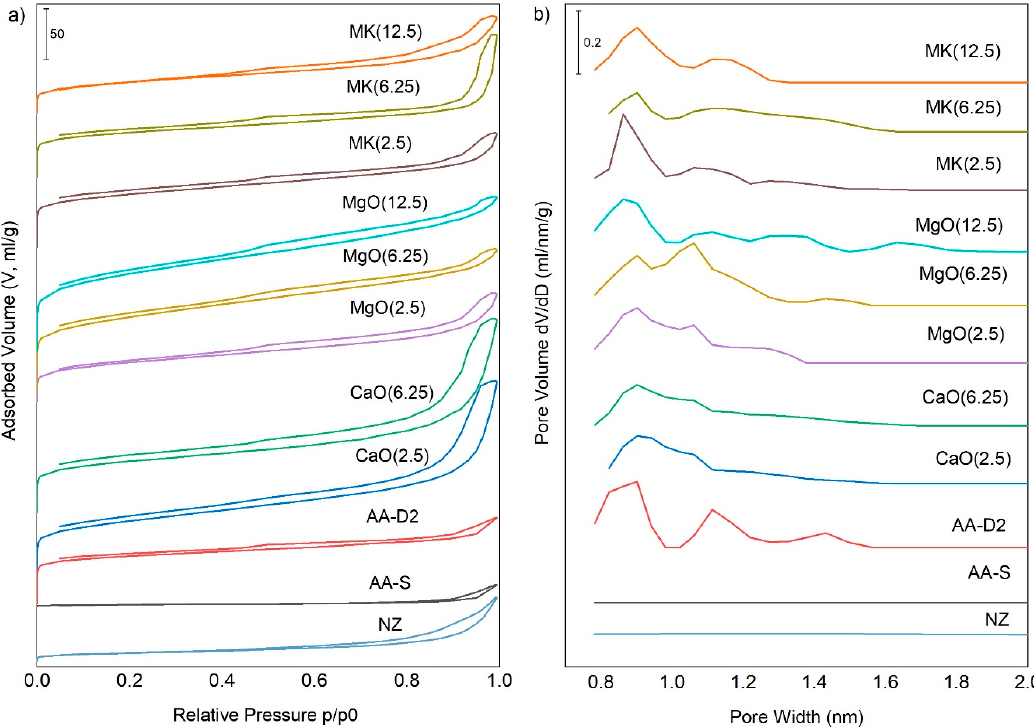
Figure 5. Nitrogen adsorption and desorption isotherms ( a ) and the distribution of micropores ( b ) of D2 samples.